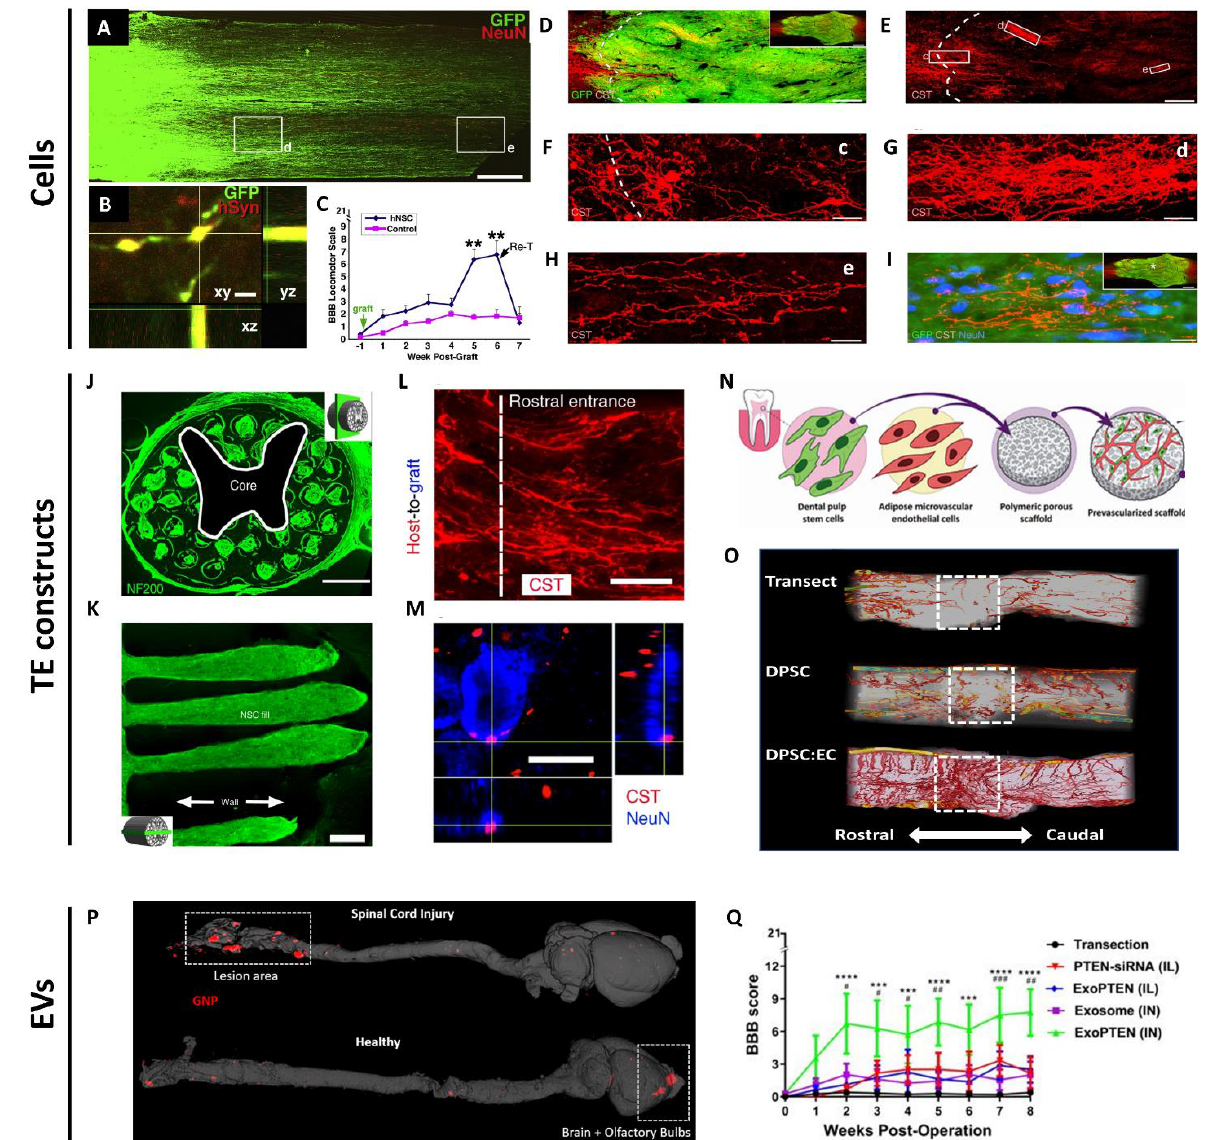
Figure 2. Examples of biological interventions using cells, tissue-engineered constructs or extracellular vesicles for spinal cord repair. ( A ) GFP-labeled human neurons robustly extend axons into the host spinal cord caudal and rostral to the complete T3 transection site (caudal shown). (d) and (e) demonstrate axonal extensions from human neurons close to and far away from the engrafted site. ( B ) GFP-labeled human axon terminals express human-specific synaptophysin (red) in host gray matter. ( C ) Functional recovery after human NSC grafts to sites of T3 complete transection, but re-transection at rostral interface of graft abolished the effect. ** p < 0.01. Reproduced with permission from Lu et al. [17]. Copyright 2012 Elsevier. ( D – I ) Corticospinal tract (CST) axons (red) robustly regenerate into GFP-expressing NPC grafts and surround neurons in the center of the graft in the site of complete T3 transection site. (c – e) in ( F – H ) represent higher magnifications of corresponding rectangles from ( E ) Reproduced with permission from Kadoya et al. [18]. Copyright 2016 Springer Nature. ( J ) A cross-section through an implanted biomimetic 3D-printed scaffold labeled for axons (NF200). ( K ) The scaffold channels are structurally intact and filled with GFP-expressing NSCs 6 months post transplantation. ( L , M ) CST axons (red) penetrate the scaffold, extend linearly in a caudal direction, and come into contact with NeuN-labeled neurons (blue) inside the channel. Reproduced with permission from Koffler et al. [33]. Copyright 2019 Springer Nature. ( N ) Schematic illustration of fabricating prevascularized tissues by co-culturing DPSCs and endothelial cells on PLLA/PLGA scaffolds. ( O ) 3D reconstruction of vasculature (red) spanning the lesion segment (dashed boxes) in transection control, DPSC-scaffolds, or prevascularized scaffold groups 8 weeks post-treatment. Reproduced with permission from Guo et al. [34]. Copyright 2020 John Wiley and Sons. ( P ) Micro-CT scanning of the CNS tissues in the injured (upper panel) and healthy rats (lower panel), after intranasal administration of gold nanoparticle (GNP)-labeled exosomes (red). ( Q ) Weekly locomotor scores of SCI rats left untreated, or treated with intralesional PTEN-siRNA or ExoPTEN, intranasal exosome (IN) or